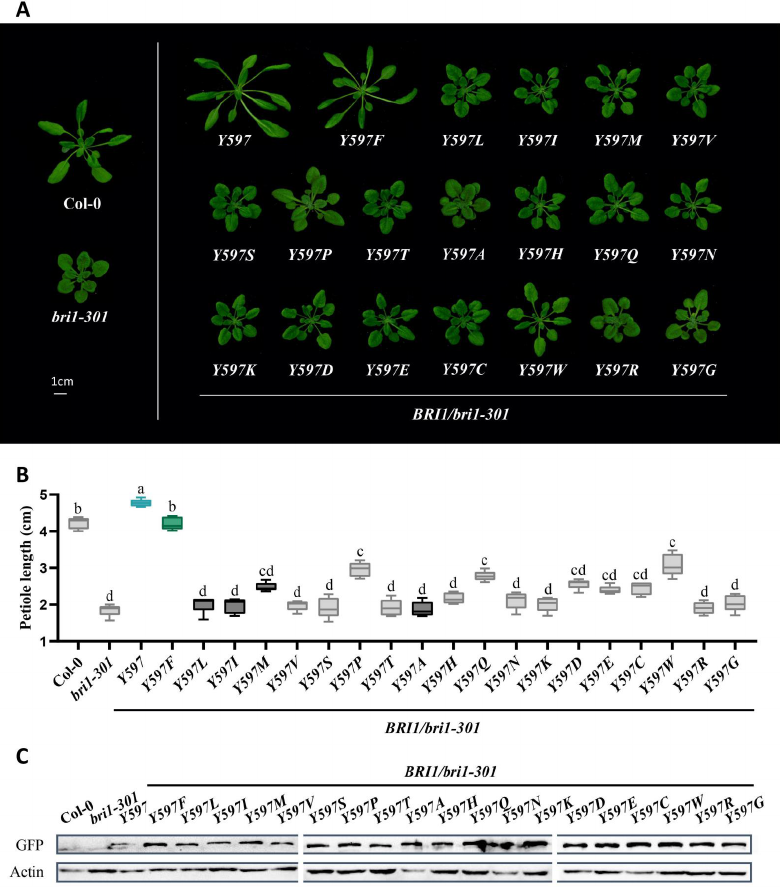
Figure 2. The tyrosine and phenylalanine of residue 597 distinguish the BR receptors from the non-BR receptor. ( A ) Phenotypes of wild-type Col-0, bri1-301 , and transgenic plants with mutated receptors expressed in bri1-301 . Four-week-old seedlings were presented. Scale bar = 1 cm. ( B ) Petiole length comparison of transgenic plants. The blue box highlights Tyrosine597 of BRI1, the green marks phenylalanine fixed in BRL1/3, the black represents the amino acids from BRL2, and the grey indicates the remaining amino acids. The results are represented as the means ± SD. Different letters indicate significant differences ( n = 15, p < 0.0001, one-way ANOVA with a Tukey’s test). ( C ) The protein expression level of mutated receptors with a GFP tag in transgenic plants. An anti-GFP antibody was used to quantify the expression